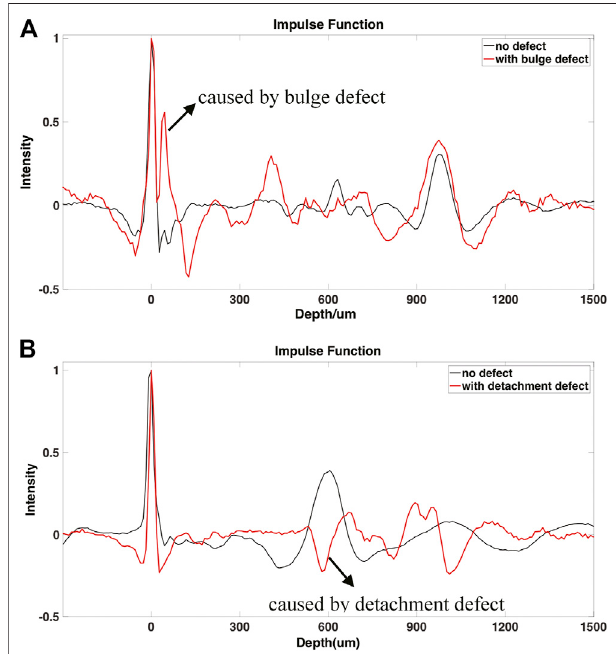
FIGURE 5 | Impulse functions of terahertz wave testing of various coating systems with paint separation. (A) With bulge defect, (B) with detachment